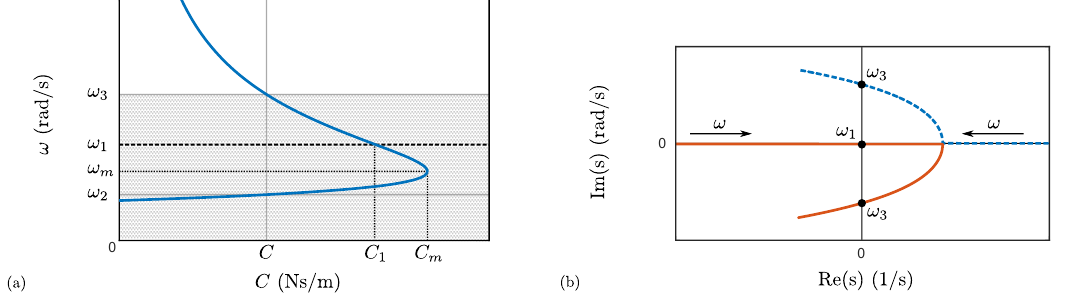
Figure 8. Stability analysis for | k e | ∈ [ 3 k ∞ ; k ∞ ] : ( a ) evolution of the spin speeds ω 1 , ω 2 and ω 3 with 4 the external damping, yielding the stable spin speed ranges; and ( b ) the corresponding root